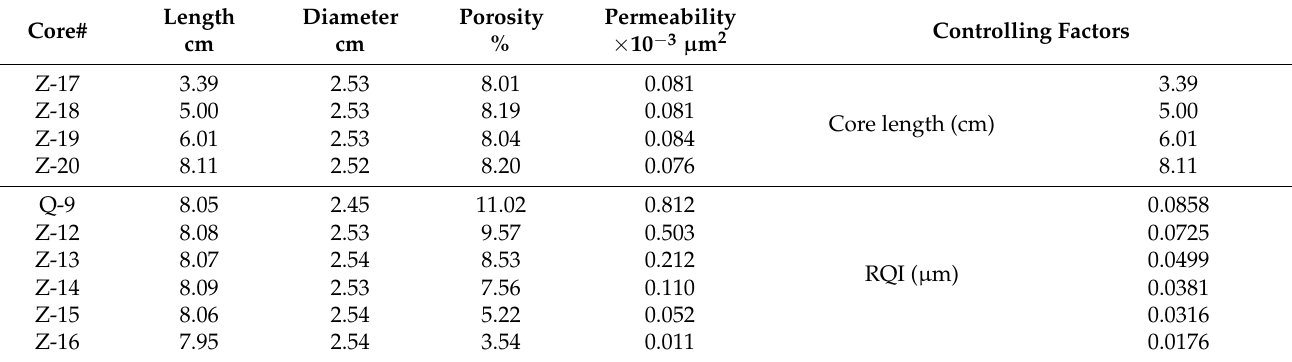
Table 1. Petrophysical properties of cores and controlling factors of imbibition.